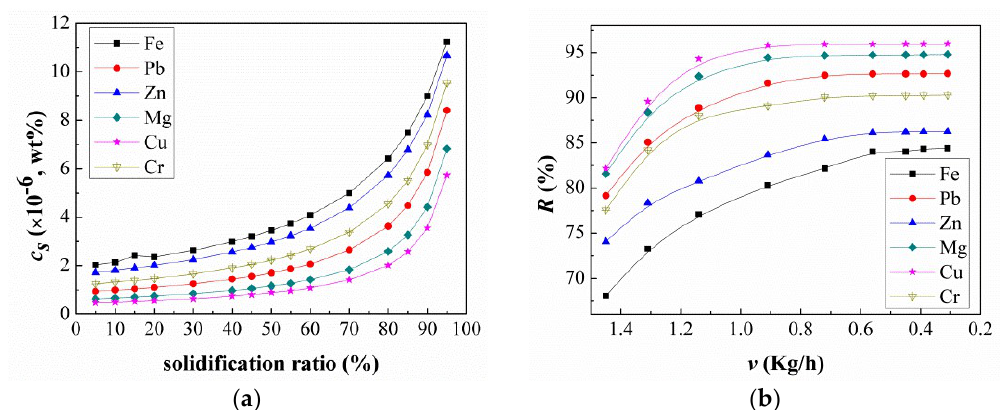
Figure 4. ( a ) Regularity of element impurity redistribution. C s is the impurity concentration in solid Ga. ( b ) Removal efficiency for each impurity’s R % at different solidification ratios.